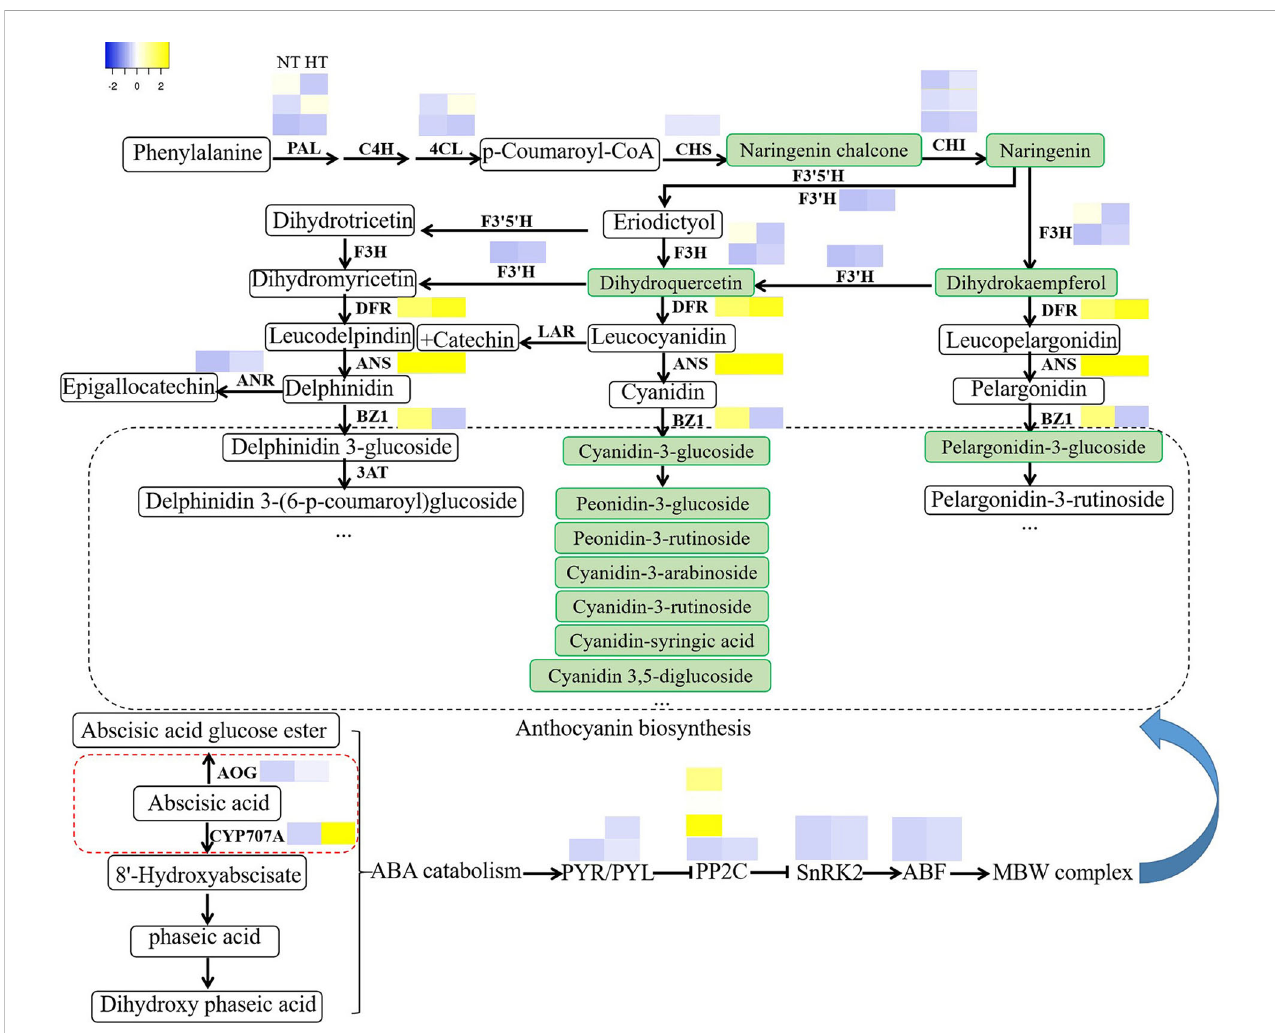
FIGURE 7 High temperature affects anthocyanin biosynthesis through the ABA catabolic pathway. DEGs from anthocyanin biosynthesis and ABA catabolism pathway genes and selected TFs were visualized as a heat map based on log 2 -fold changes obtained from high temperature treatments against the normal temperature